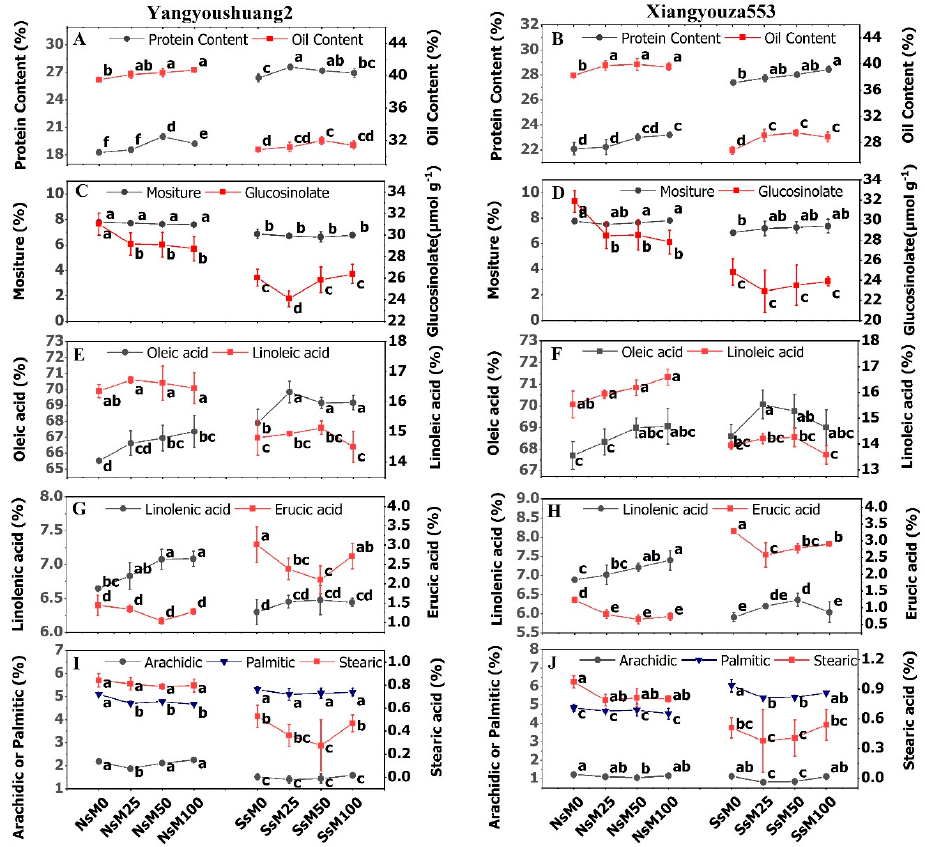
Figure 7. Effect of seed priming in 0 µM (M0), 25 µM (M25), 50 µM (M50), and 100 µM melatonin (M100) on seed protein content, oil content, moisture content, glucosinolate, and fatty acid